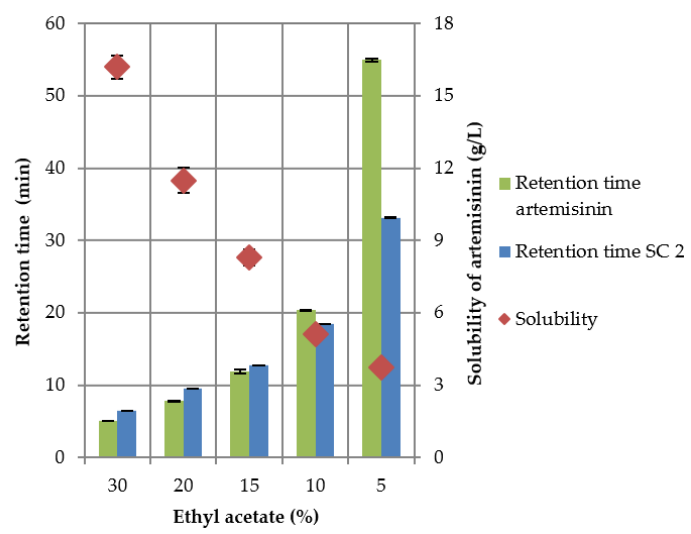
Figure 9. Retention time of artemisinin and SC2 over the ethyl acetate content. On the secondary axis is the corresponding solubility of the artemisinin.